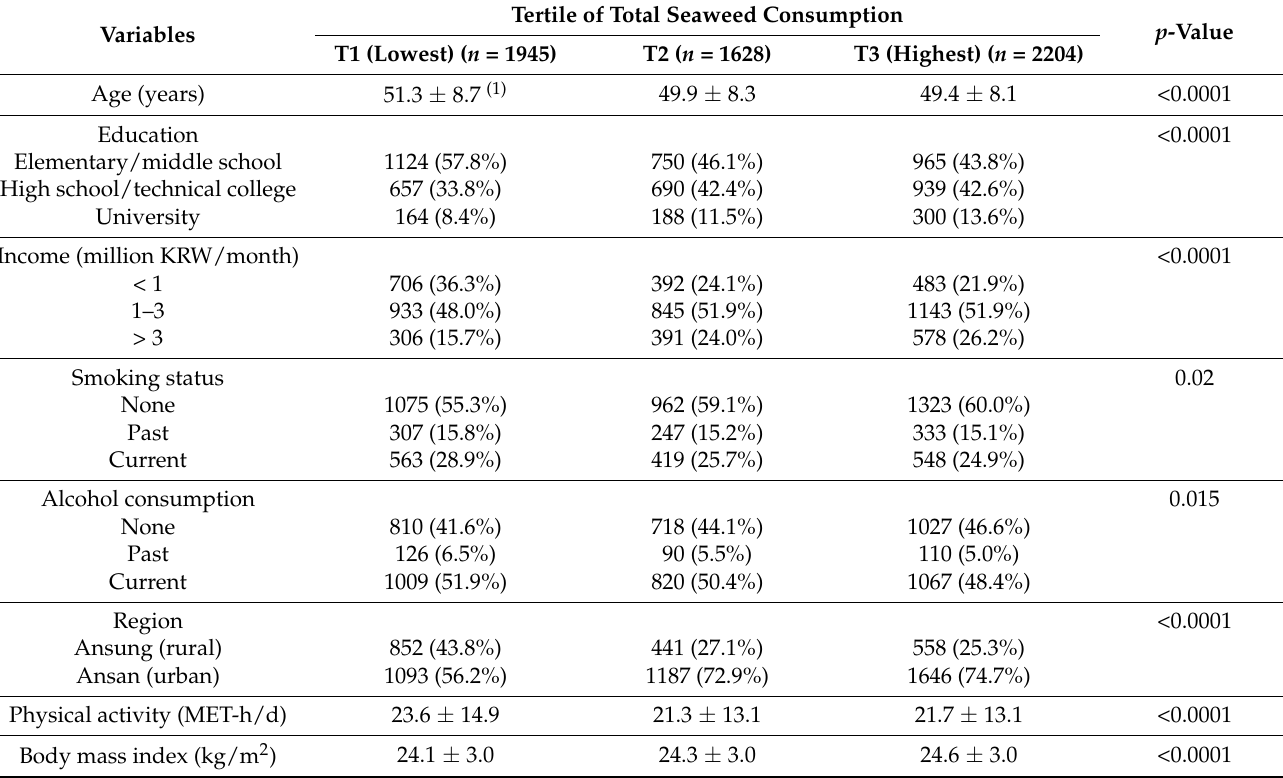
Table 1. General characteristics according to tertiles of total seaweed consumption in the Korean Genome and Epidemiology Study (Ansan and Ansung).